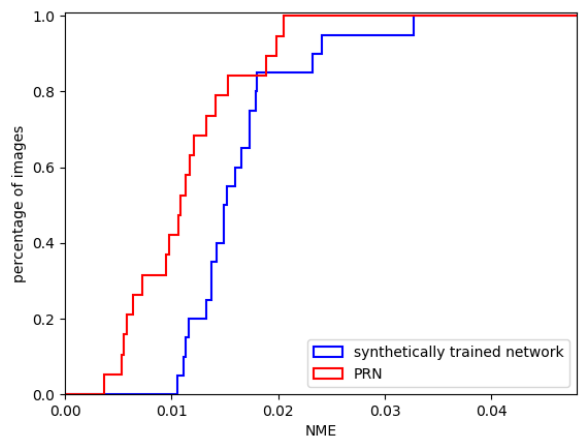
Figure 18. cumulative error distribution (CEDs) for the synthetically trained 2-input network and PRN.